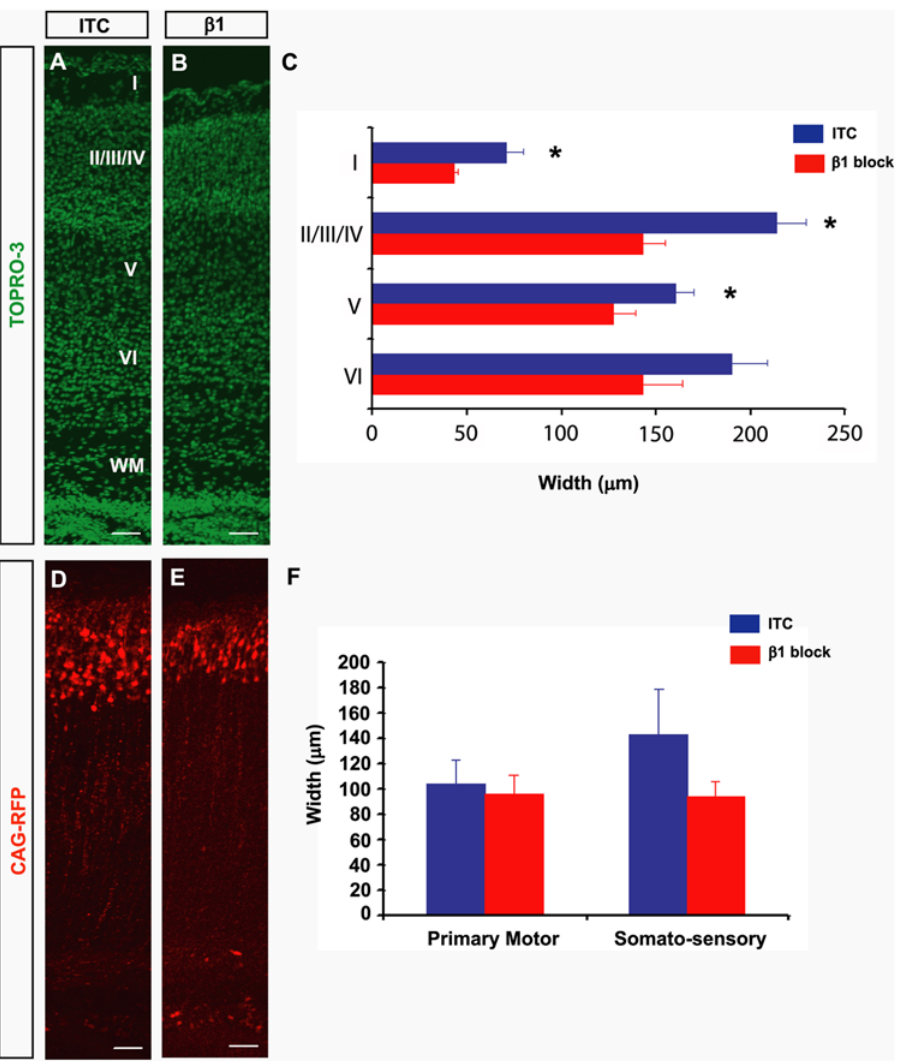
Figure 7. Inhibition of b 1 integrin signalling at E15.5 alters cortical cell layering at P4. Fluorescence micrographs of the P4 telencephalon stained with Topro-3 after injection of the ITC (A) or b 1 (B) integrin blocking antibody at E15. (C) Quantification of cortical layer thickness shows a significant reduction in the thickness of layers I–V after injection of the b 1 integrin blocking antibody (layer I: ITC=71 m m 6 8, b 1 block=43 m m 6 2, *, p , 0.02; layers II, III, IV: ITC=214 m m 6 15, b 1 block=142 m m 6 13, *, p , 0.004; layer V: ITC=160 m m 6 10, b 1 block=127 m m 6 12, *, p , 0.04; layer VI: ITC=190 m m 6 19, b 1 block=142 m m 6 21, p , 0.1). Fluorescence micrographs of the P4 telencephalon illustrating CAG-RFP + cells after injection of the ITC (D) or b 1 (E) integrin blocking antibody at E15.5. (F) Quantification of the thickness of CAG-RFP + cell layers in primary motor (PM) and somato- sensory (SS) cortices shows a reduction at the level of the somato-sensory cortex after injection of the b 1 integrin blocking antibody (PM: ITC=104 m m 6 18, b 1 block=95 m m 6 16, p , 0.7; SS: ITC=143 m m 6 35, b 1 block=93 m m 6 14, p , 0.3). n =2 ITC and 3 b 1 integrin blocking antibody- injected embryonic brains, 6 SEM. Statistical analysis was done using an unpaired two-tailed t -test, *, p , 0.05. All scale bars represent 50 m m.